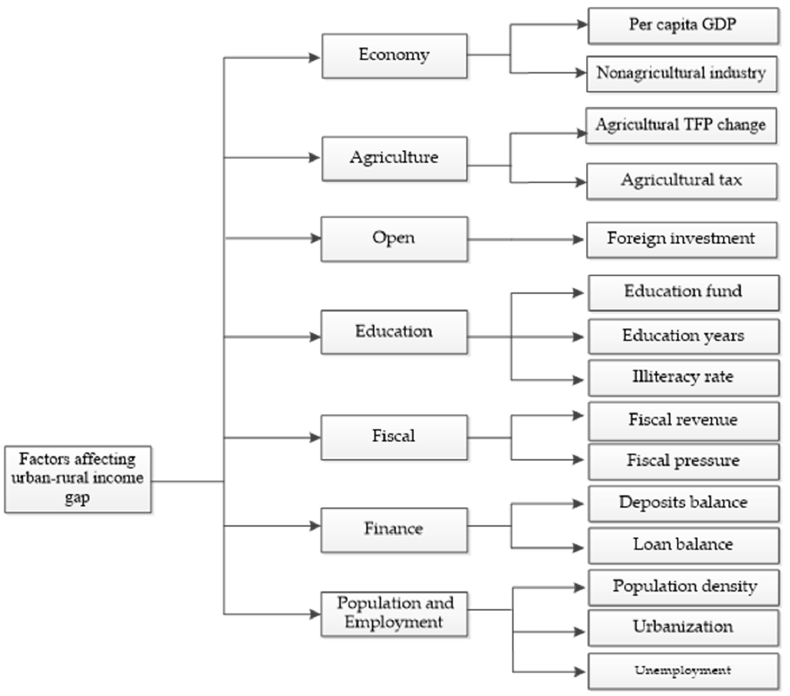
Figure 2. Indicators to identify determinants of the rural–urban income gap.